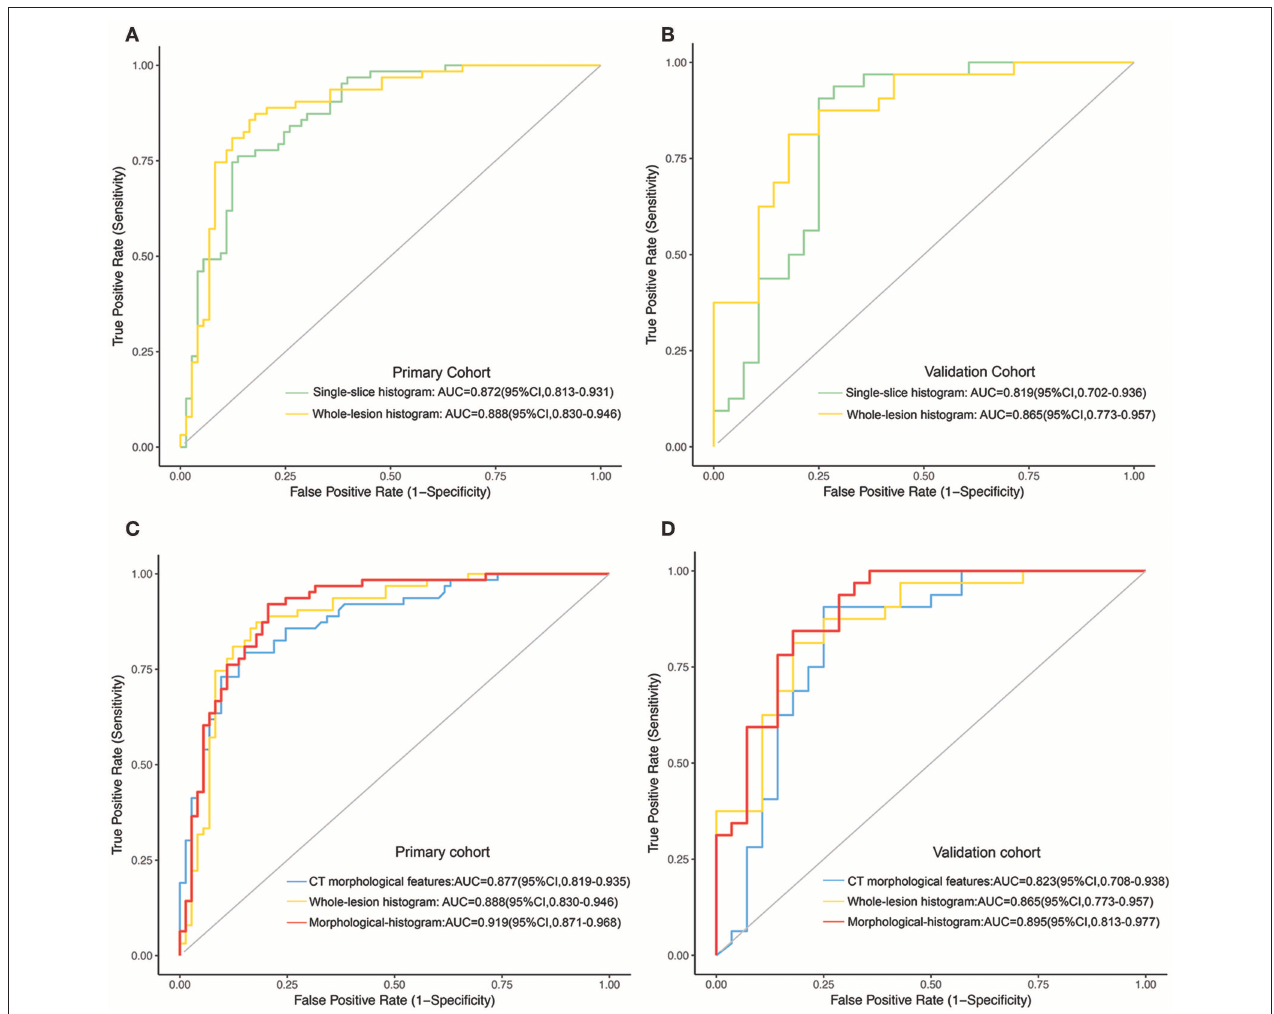
FIGURE 3 | (A,B) The ROC curves of the single-slice histogram model and whole-lesion histogram model in the training (A) and validation sets (B) , respectively. (C,D) The ROC curves of the CT morphological model, the whole-lesion histogram model and the integrated morphological-histogram model in the training (C) and validation cohorts (D) ,